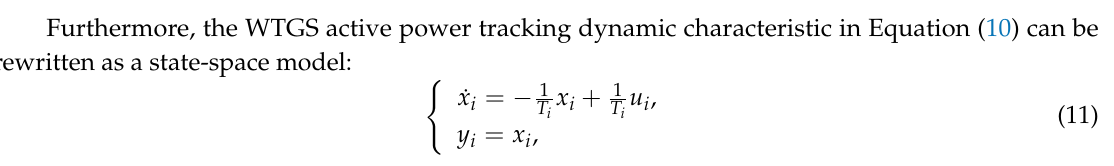
Figure 2. Wind turbine power tracking dynamic